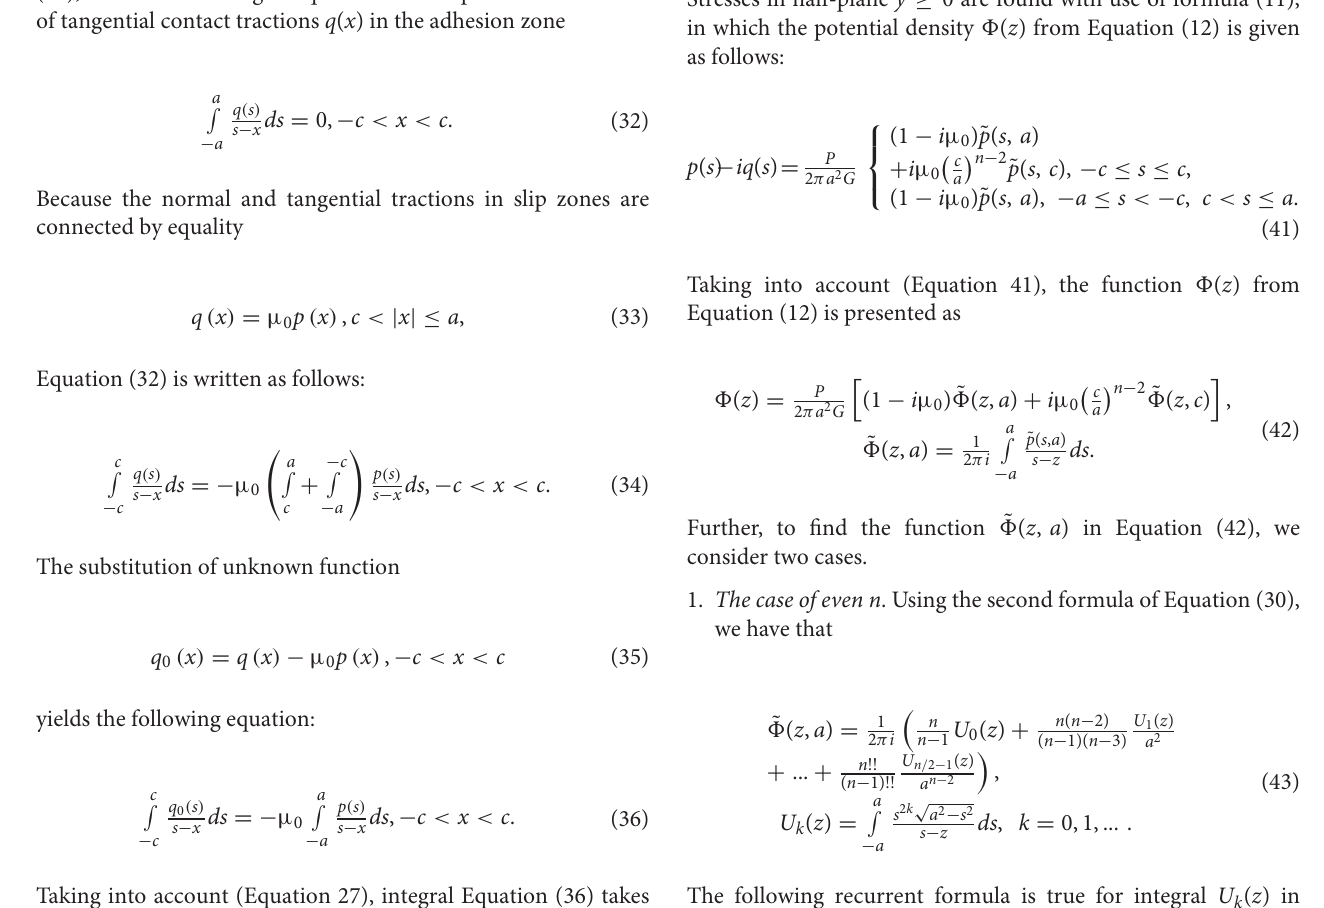
p ( x ) for different n ¯